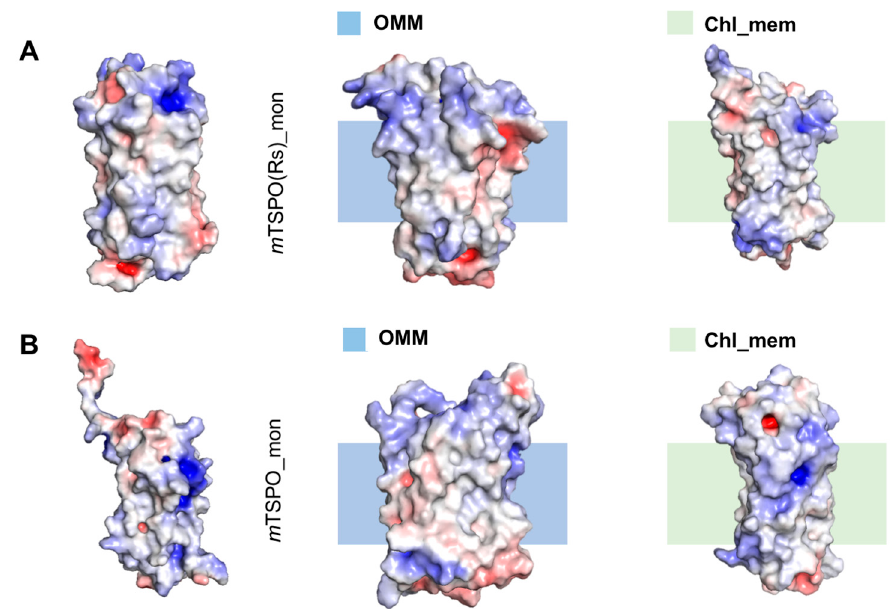
Figure 5. Electrostatic surface potential of the initial and equilibrated conformations, extracted from the trajectories after convergence (7.5 µ s) and backmapped to all-atom resolution with the amber force field [33] using backward.py [31] of m TSPO(Rs)_mon ( A ) and m TSPO_mon ( B ) embedded in OMM and chl_mem. Red and blue surfaces represent negative and positive electrostatic potentials ( − 5 kT / e, + 5kT / e)